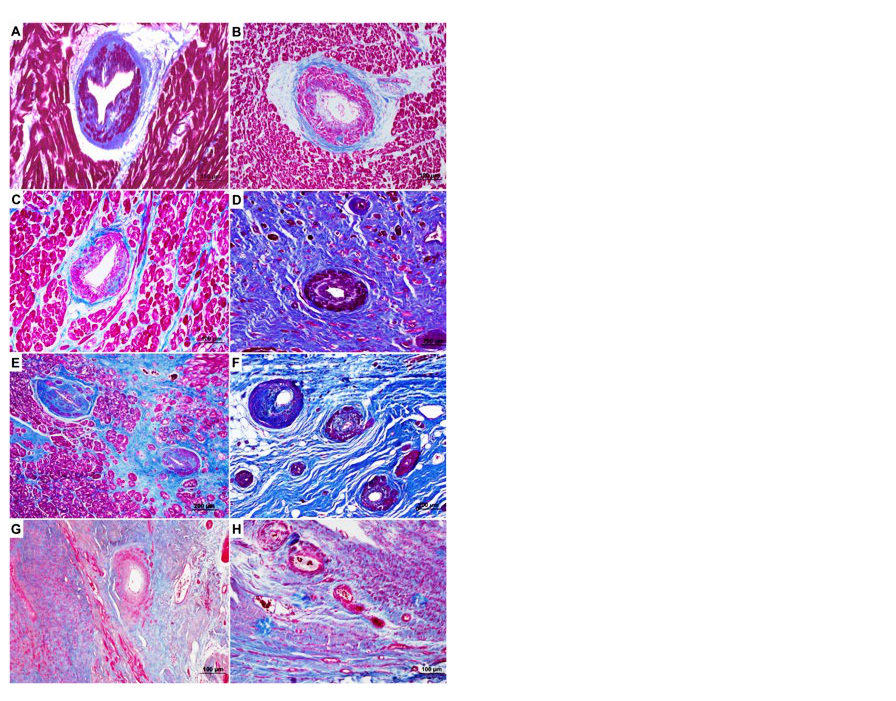
Figure 1. Pathologic appearance of small vessel disease (SVD) in HCM. ( A , B ) HCM patient with SVD in the absence of replacement-type fibrosis. ( C , D ) SCD-HCM patient with SVD in areas without ( C )